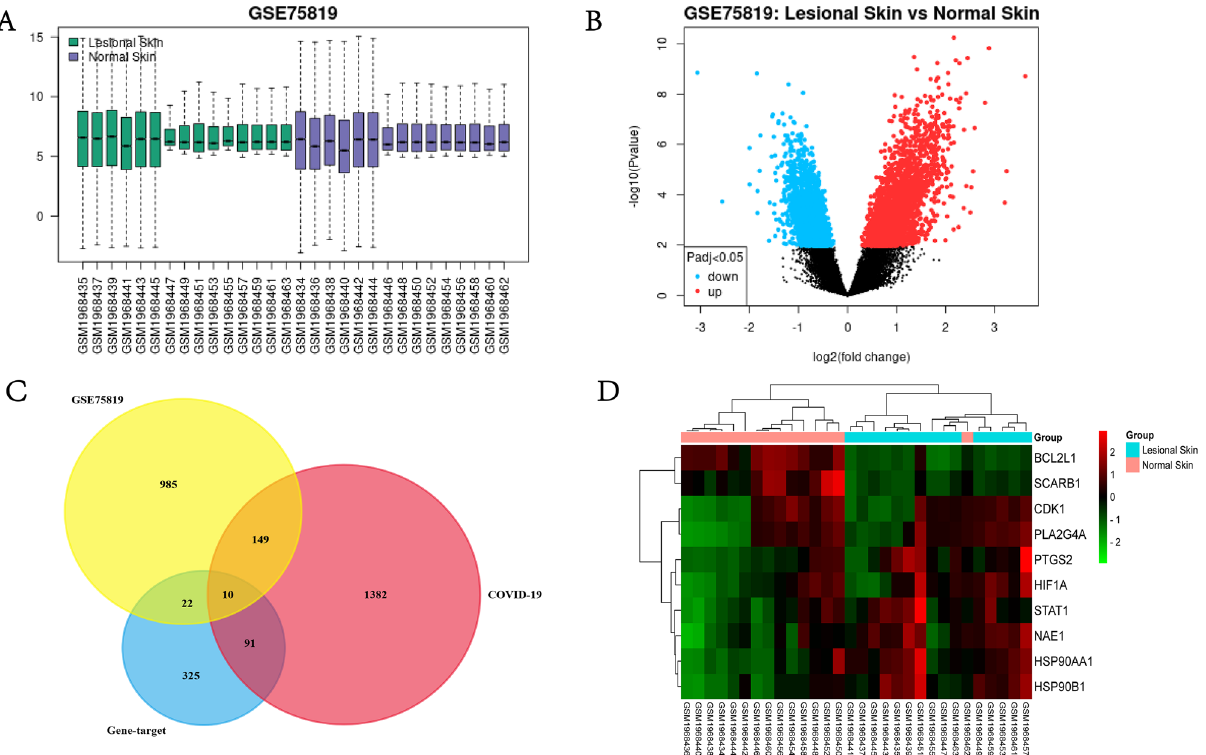
Figure 3. Cross-gene screening of Astragalus in the treatment of vitiligo and COVID-19. ( A ) Quality assessment of the dataset GSE75819. ( B ) Up- and down-regulation relationships of differentially expressed genes in the dataset GSE75819, represented by volcano plots. Up-regulated genes are represented in red, Down- regulated genes are represented in blue. ( C ) Crossover gene screen between GSE75819, drug target and COVID- 19. ( D ) Clustering analysis of crossover genes between vitiligo lesioned skin and normal human skin in the GSE75819 dataset. Red represents up-regulated expression and green represents down-regulated expression.